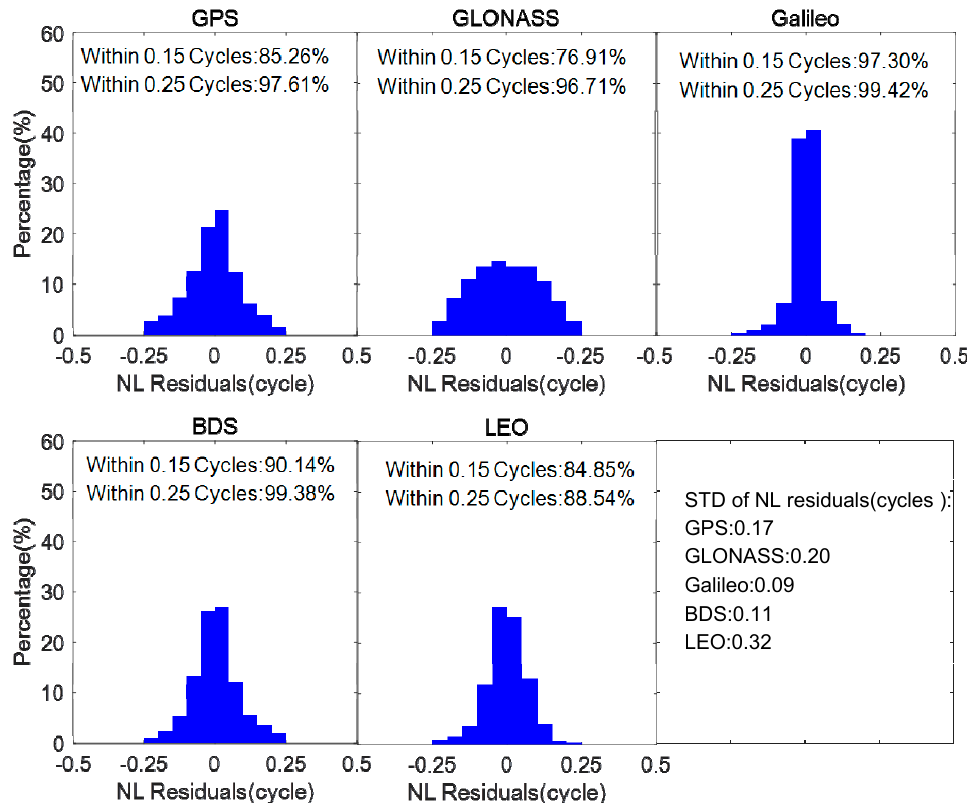
Figure 5. Residual distribution of narrow-lane UPDs for GPS, GLONASS, Galileo, BDS, and